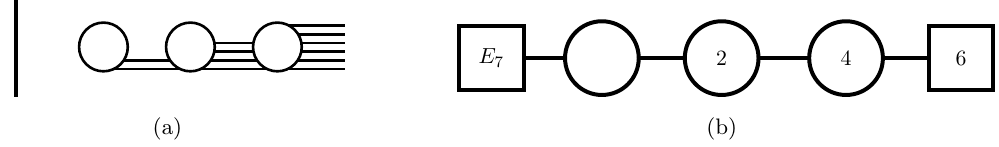
Figure 5 . In (cid:12)gure (a), the brane diagram whose near-horizon limit produces the solution (5.3) for n 0 = 2 and N = 3 is depicted. The vertical line represents an O8-plane with n 8 = 8 in this case) D8-brane pairs. The nodes denote NS5-branes, and the horizontal lines D6-branes. In (cid:12)gure (b), the quiver diagram of the corresponding (cid:12)eld theory for this particular case is depicted. The empty node represents the E-string theory, as explained in the main